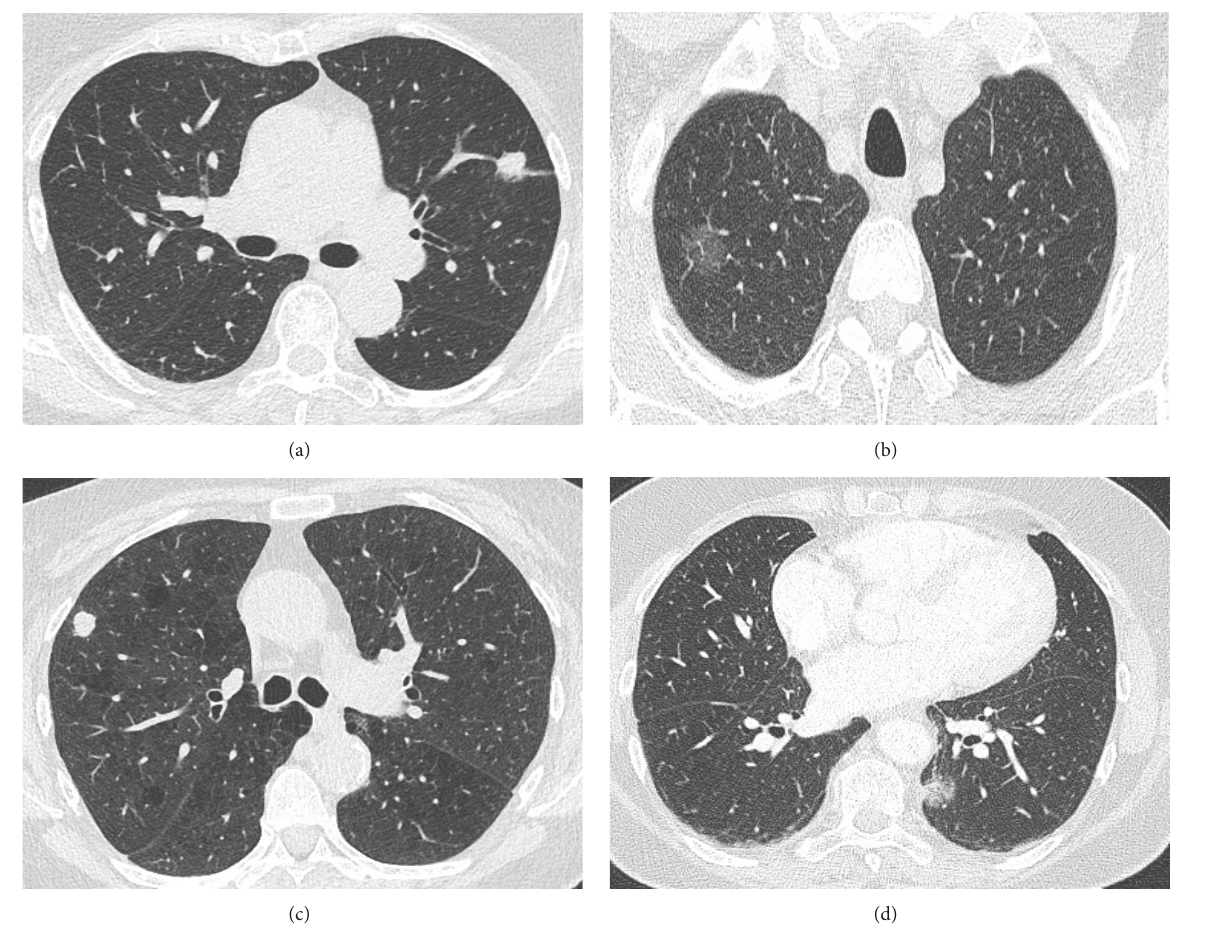
Figure 2: CT scans in four representative patients. Panel (a) presents a solid nodule of 16mm in diameter in the left upper lobe in a 75-year- old woman. The final diagnosis was tuberculosis. Panel (b) presents a nonsolid nodule of 20mm in diameter in the right upper lobe in a 57-year-old man. The final diagnosis was lung adenocarcinoma. Panel (c) presents a solid nodule of 11 mm in diameter in the right upper lobe in a 72-year-old woman. The final diagnosis was small cell lung carcinoma. Panel (d) presents a nonsolid nodule of 14 mm in diameter in the left lower lobe in a 67-year-old woman. The final diagnosis was lung